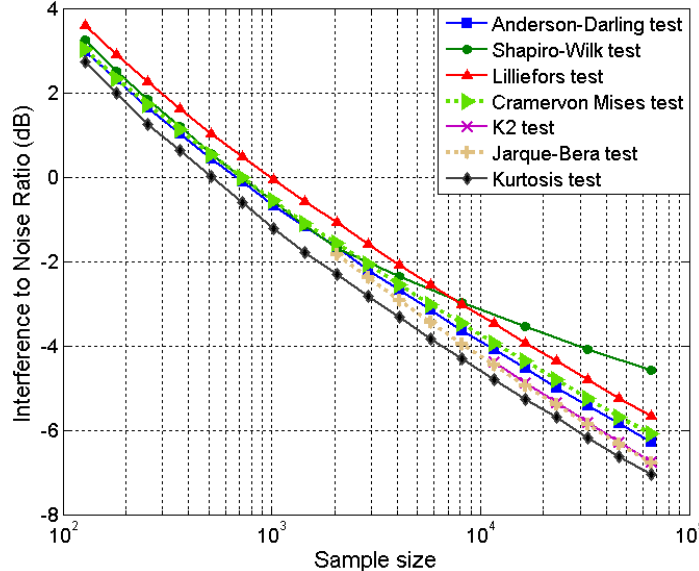
Figure 8. Normality test performance in the detection of a PRN interference as a function of the signal’s sample size. Graphs represent the INR value required to obtain a ROC curve with a P = 0.1 for P = 0.9. Kurtosis test has the best performance, followed by JB and fa det K2 tests. Best ECDF test performance is obtained with the AD test followed by the